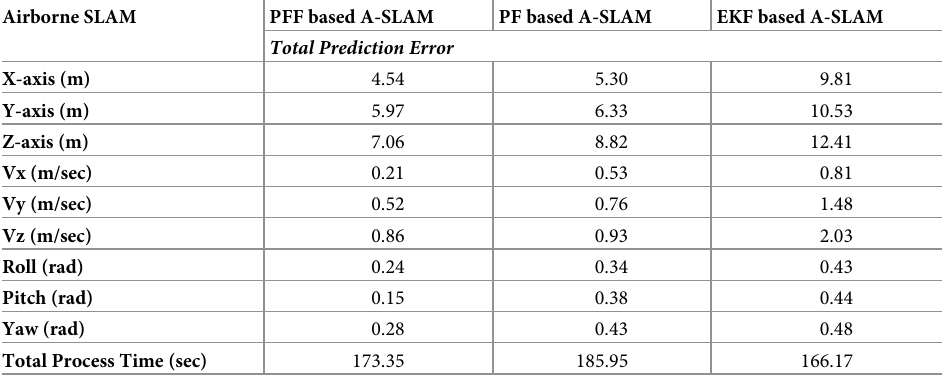
Table 1. Case study 1–performance comparison: SLAM methods prediction error and process time. Airborne SLAM